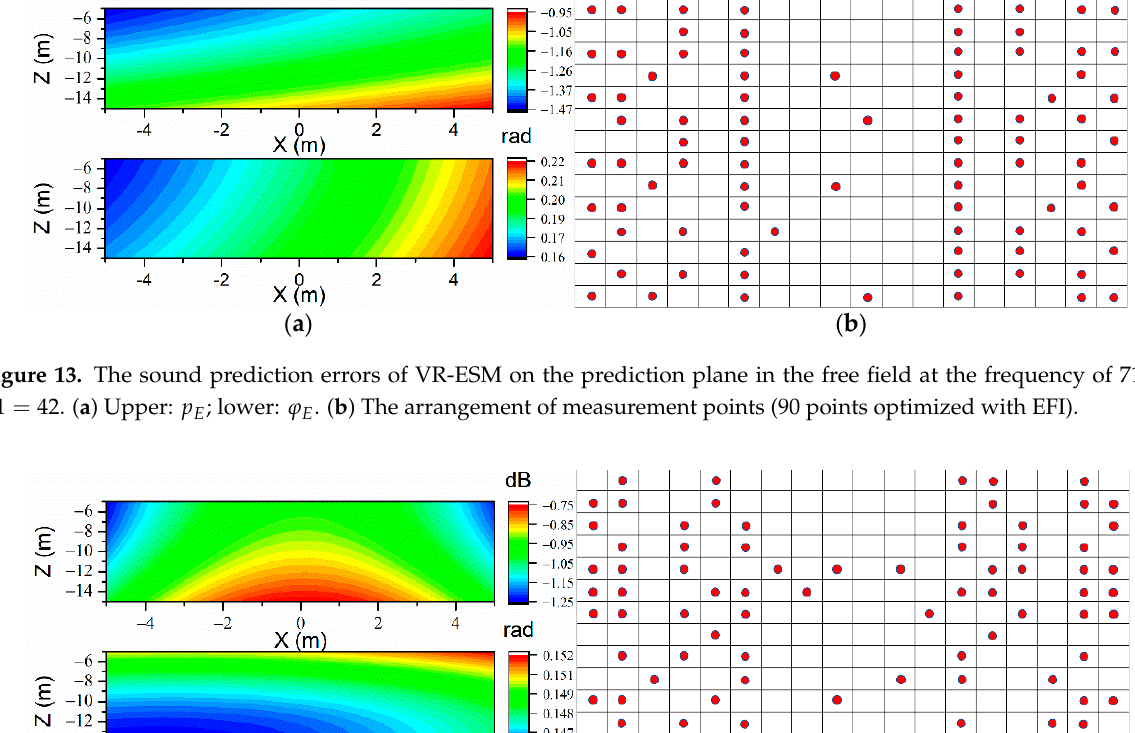
Figure 12. ( a ) The variation of 𝛾 (cid:4593) with the increase of ARM order, ( b ) the variation of reconstruc- tion error versus the ARM order ( 𝑓 (cid:2868) = 71 Hz , ℎ (cid:3022) = 0.2 m ), and ( c ) the arrangement of test points.